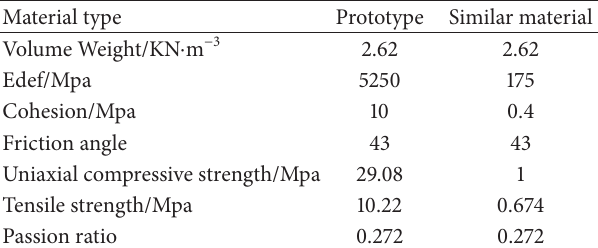
Table 1: Physical-mechanical parameters of the prototype rock and model material.